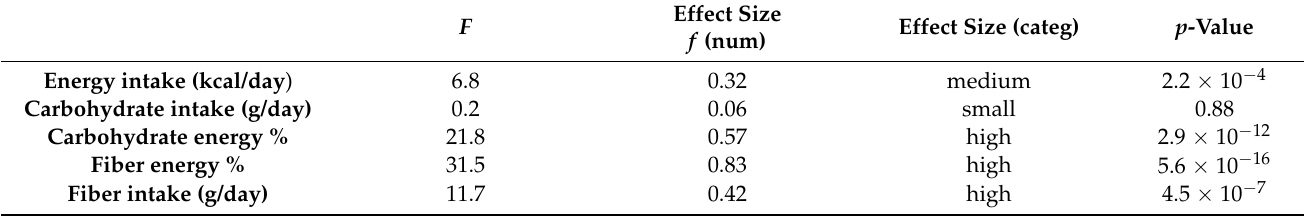
Table 5. One-way ANOVA test of energy intake, carbohydrate intake, and fiber intake across all dietary forms.